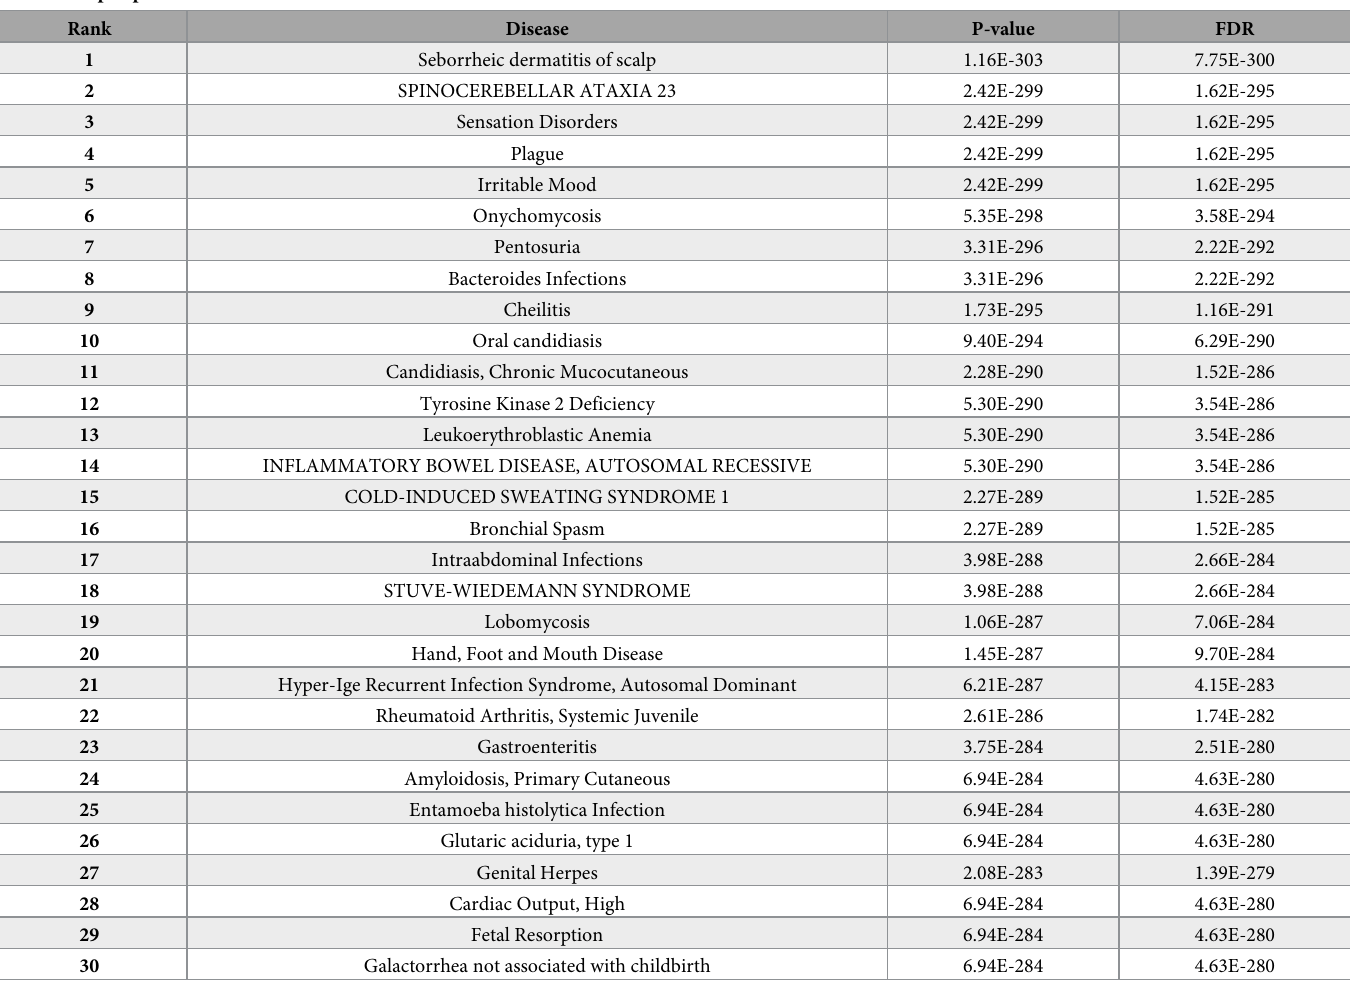
Table 2. Top30 predicted indications for